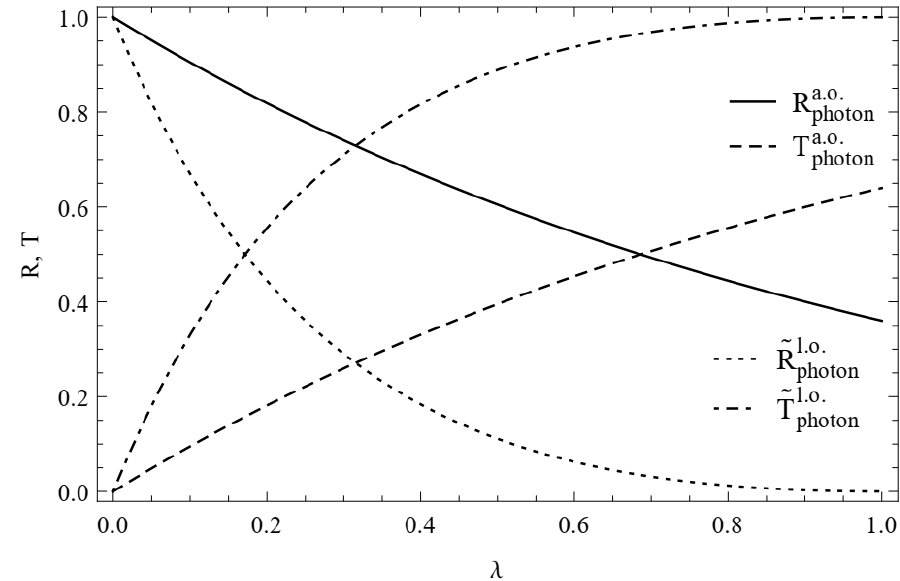
Figure 1. Fresnel coefficients of DSWH for asymptotic and local